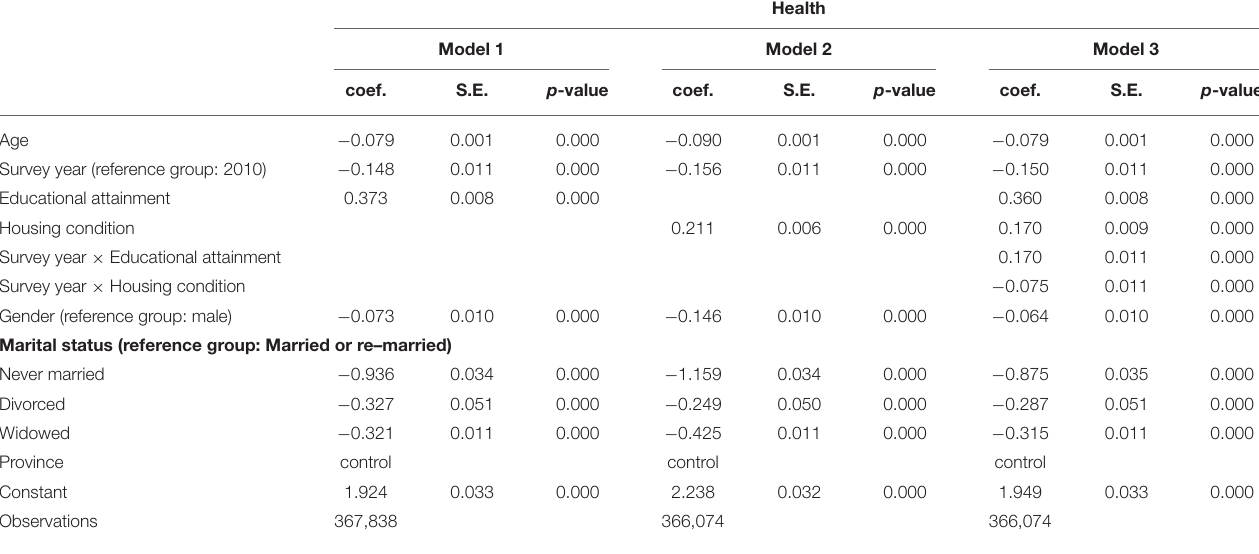
TABLE 3 | Binary logistic regression models of the SES